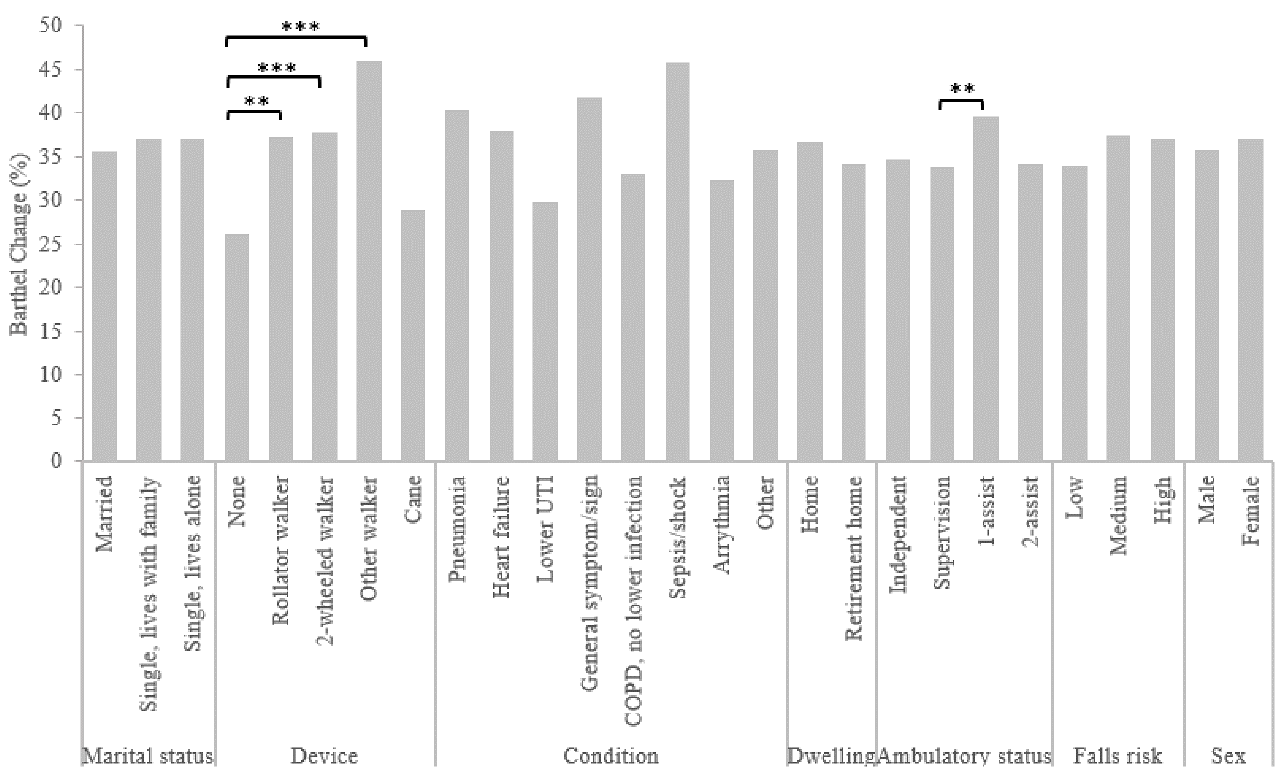
Figure 1. Functional change from admission to discharge based on chosen predictors in HEART participants. ** p < 0.01, *** p < 0.001. UTI, urinary tract infection; COPD, coronary obstructive pulmonary.